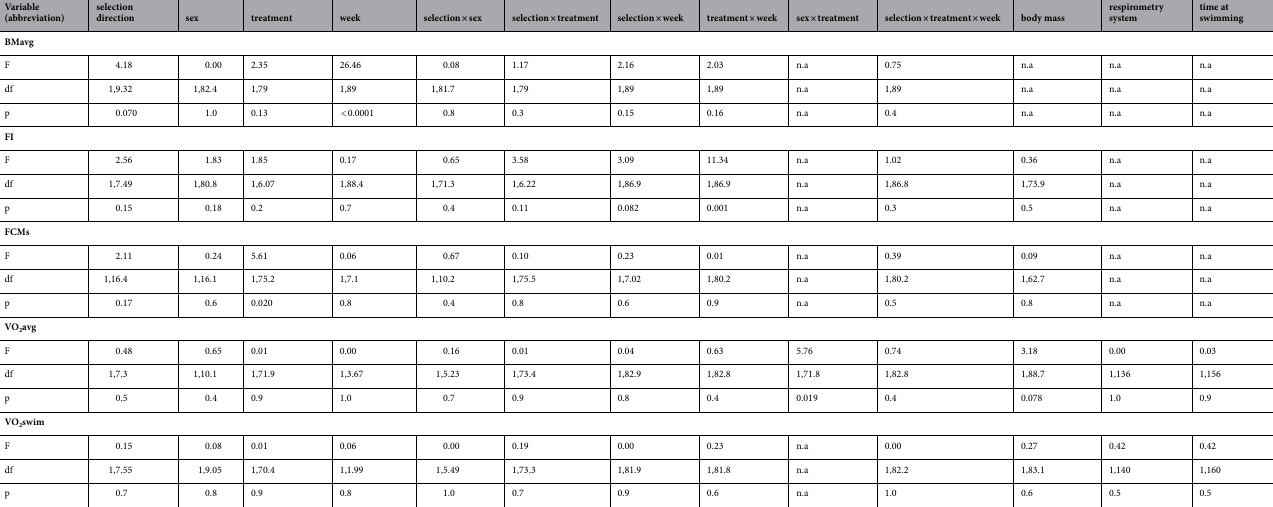
Table 4. Results of ANCOVA models performed on scopes of deviation from initial trait values during the experiment. Treatment and its interaction with other factors represent the effect of the CMS treatment, relative to the “comfort” group. Significance of fixed factors, covariates and interactions on body mass averaged over 4 days (BMavg), apparent daily food intake rate (FI), fecal corticosterone metabolites (FCMs), and measures of swimming metabolism: average oxygen consumption (VO 2 avg) and maximum 1-min oxygen consumption